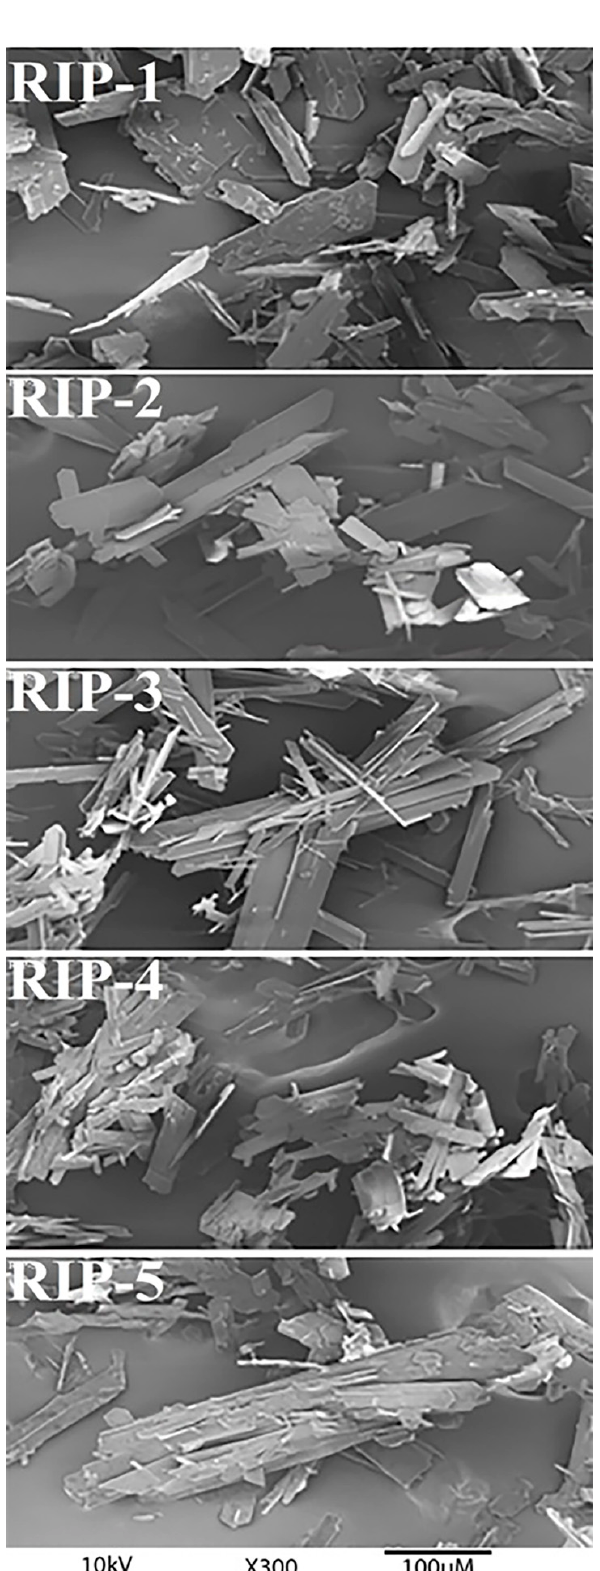
Figure 1. Scanning electron microscopic photographs of riparin I batches.